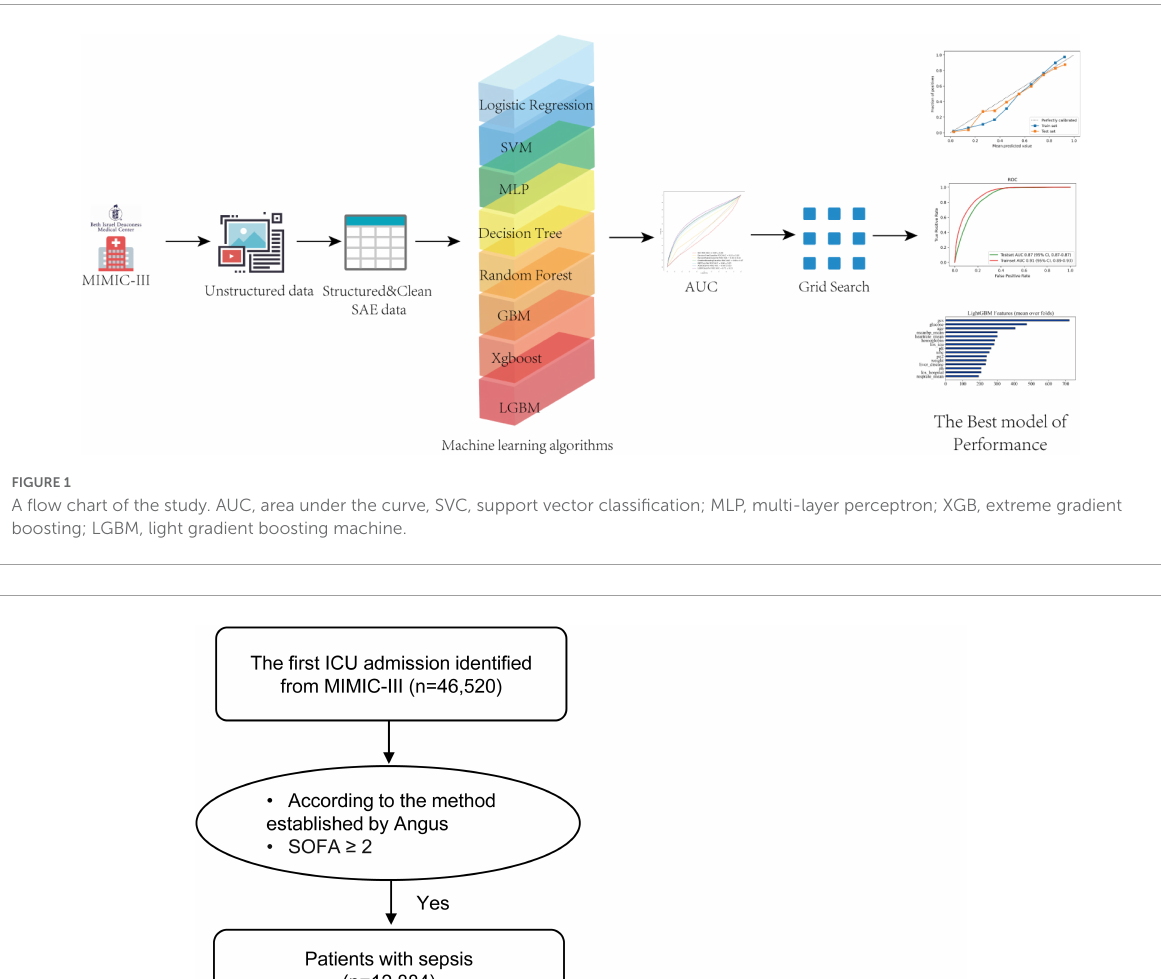
the most common (4,554 of 6,284, 72.5%)